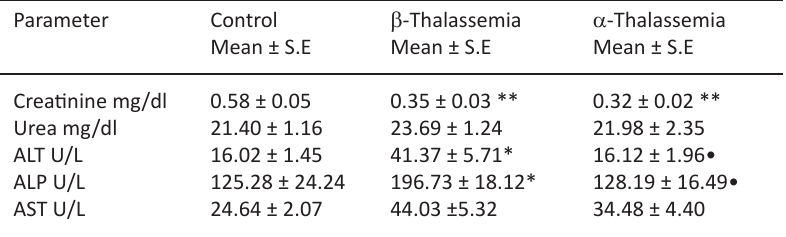
Table 3. Correlation between study parameters in a -thalassemia and β -thalassemia patients. Correlation between study Parameters in alpha thalassemia patients ( No.=22) Ferritin ng/ml